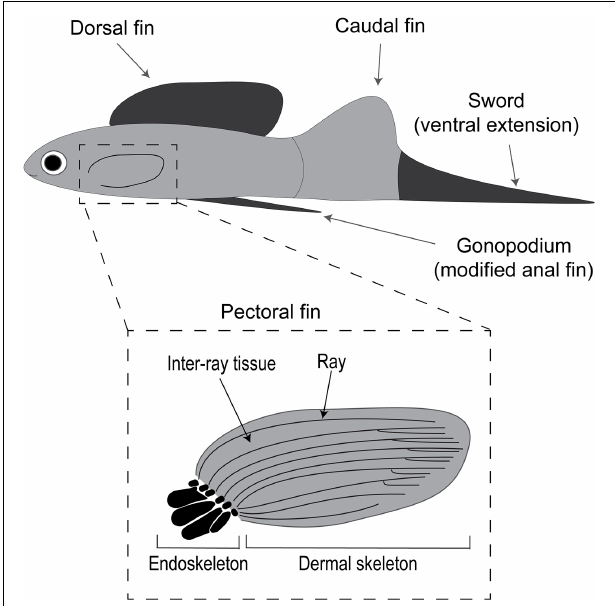
FIGURE 2 | Sexual and natural selection have driven modifications in male fin morphology and function in the fish family Poeciliidae. The different fins types include the paired pectoral fins and the single dorsal, caudal and anal (in males modified into a copulatory organ called the gonopodium) fins. The dashed square inset shows the structure of archetypical fins in Actinopterygii (ray-finned) fishes highlighting the endoskeleton (in black; only present in paired fins) and the dermal skeleton or exoskeleton (present in both paired and single